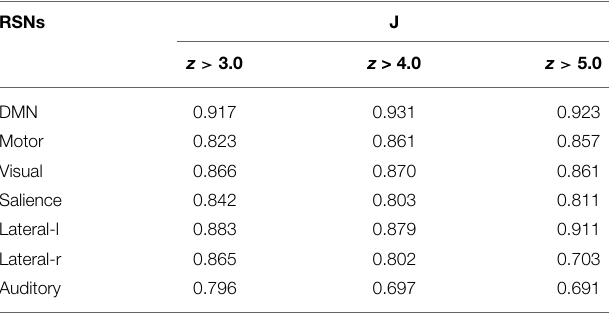
TABLE 2 | Comparison of seven RSNs generated with our method with an offline method. RSNs J